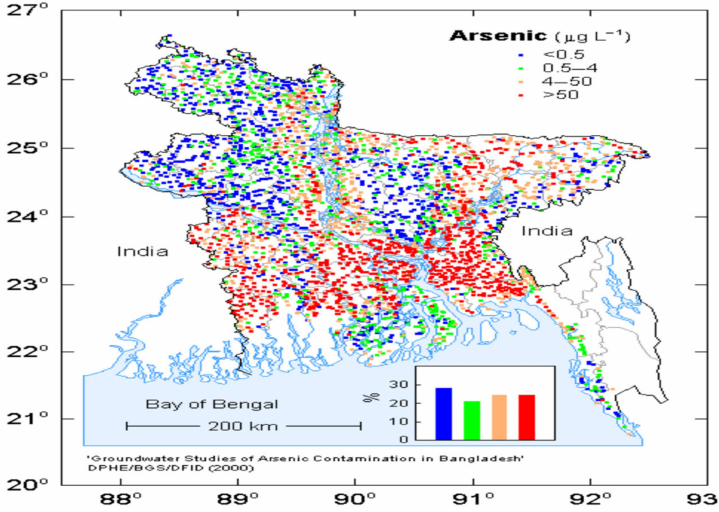
Figure 4. Arsenic contaminated areas in Bangladesh [24]. Reproduced with permission from